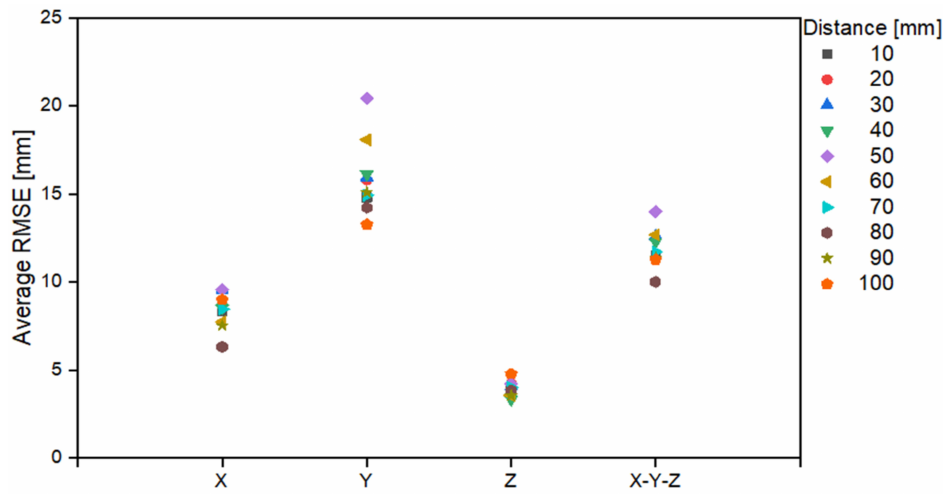
Figure 10. RMSE graph based on the Z distance.